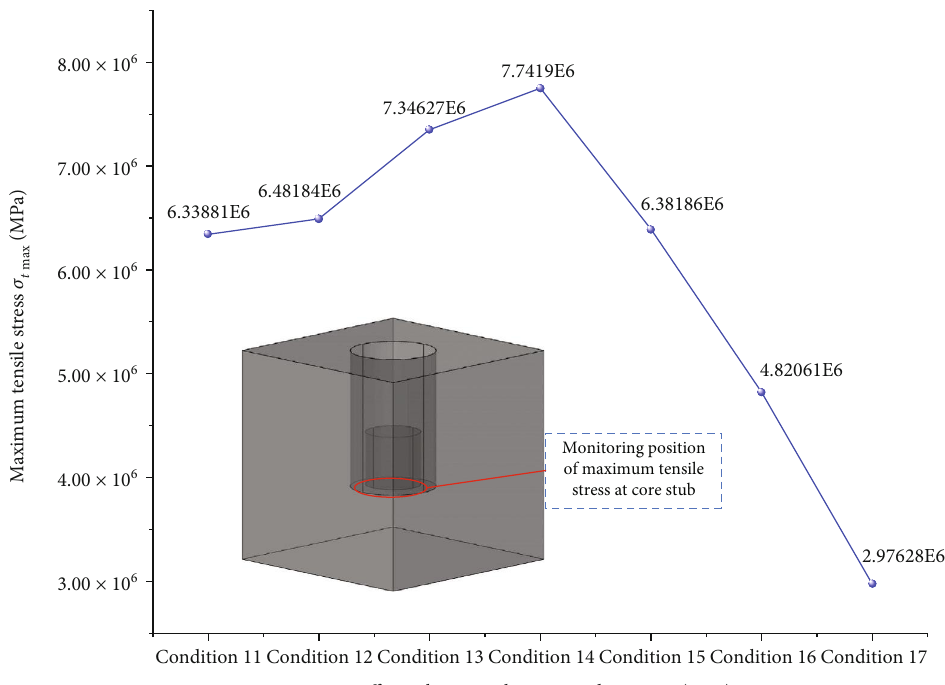
ff erent in situ stress combinations. (a) Di ff erent hydrostatic pressure Figure 3: Variation of the maximum tensile stress σ t max with di combinations. (b) Di ff erent axial stress combinations. (c) Di ff erent horizontal stress